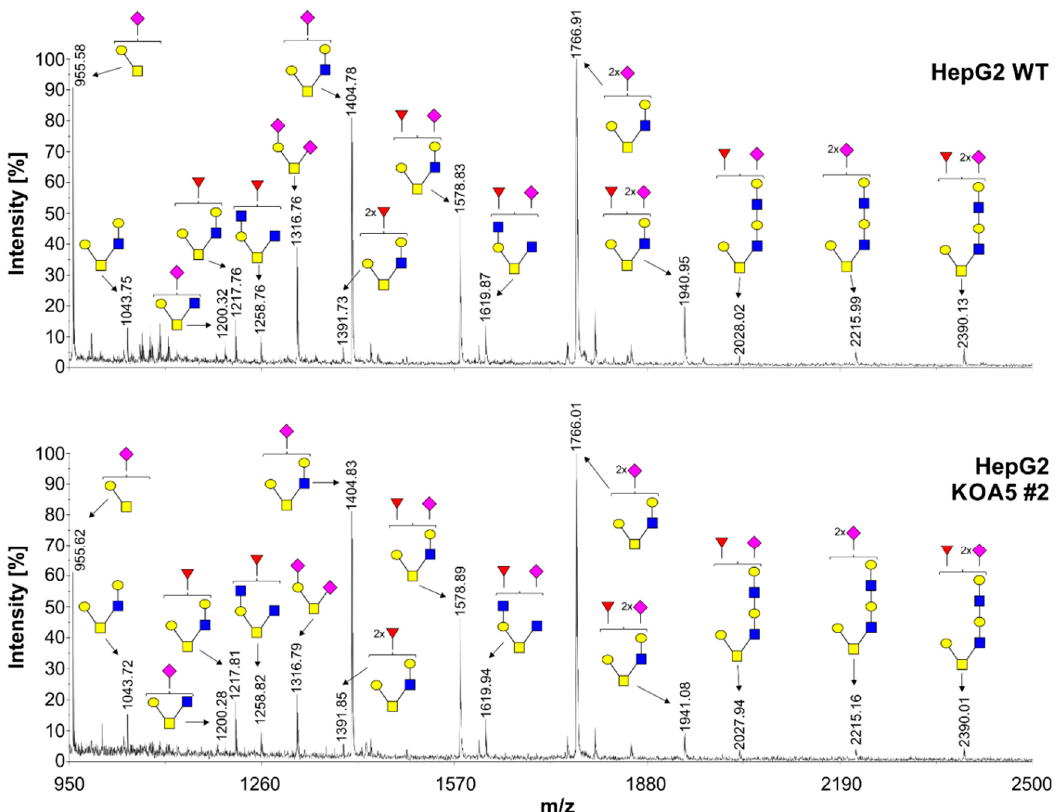
Figure 2. Structural analysis of O -glycans isolated from wild-type and SLC35A5-deficient HepG2 cells. Permethylated Bn- O -glycans secreted to culture medium were characterized using MALDI-TOF mass spectrometry. Blue squares, N -acetylglucosamine; yellow squares, N -acetylgalactosamine; yellow circles, galactose; red triangles, fucose; pink squares, sialic acid.